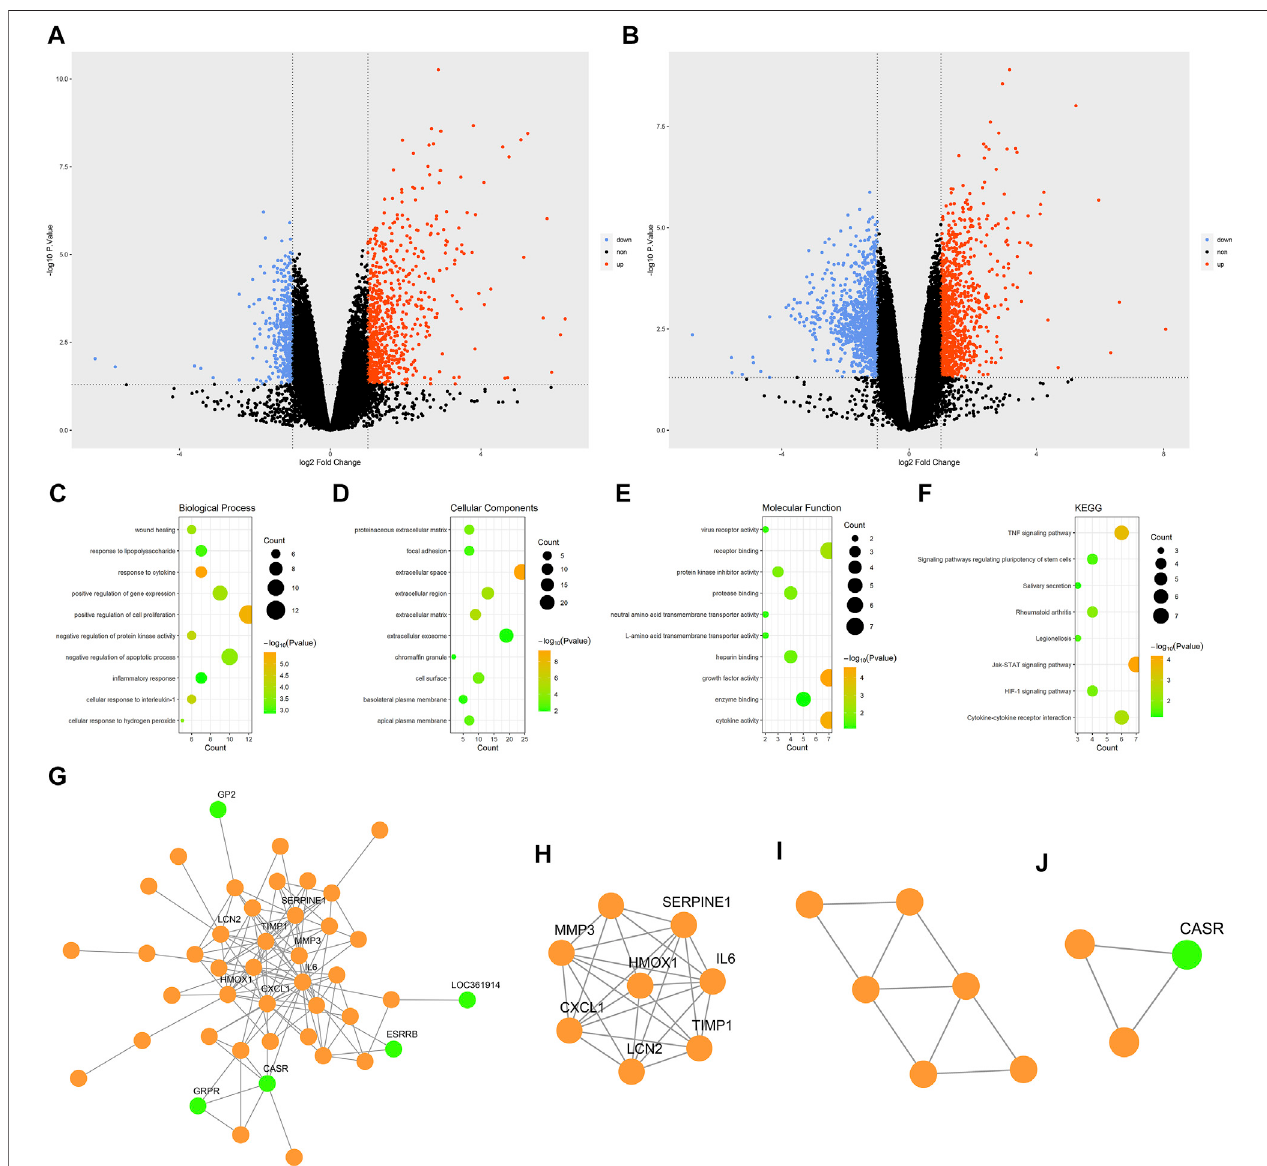
FIGURE 2 | Bioinformatic analysis. (A) Volcano plot showing DEGs for the Ctr vs IR_3h comparison. (B) Volcano plot showing DEGs for the Ctr vs IR_24h comparison. (C) The top 10 GO BP terms. (D) The top 10 GO CC terms. (E) The top 10 GO MF terms. (F) KEGG pathway enrichment results. (G) PPI network. (H) Functional cluster 1. (I) Functional cluster 2. (J) Functional cluster 3. Green dots in the G-J panel are used to denote downregulated hub genes.; Abbreviations: DEGs, differentially expressed genes; Ctr, control; IR, ischemia-reperfusion; GO, gene ontology; BP, biological process; CC, cellular component; MF, molecular function; KEGG, Kyoto Encyclopedia of Genes and